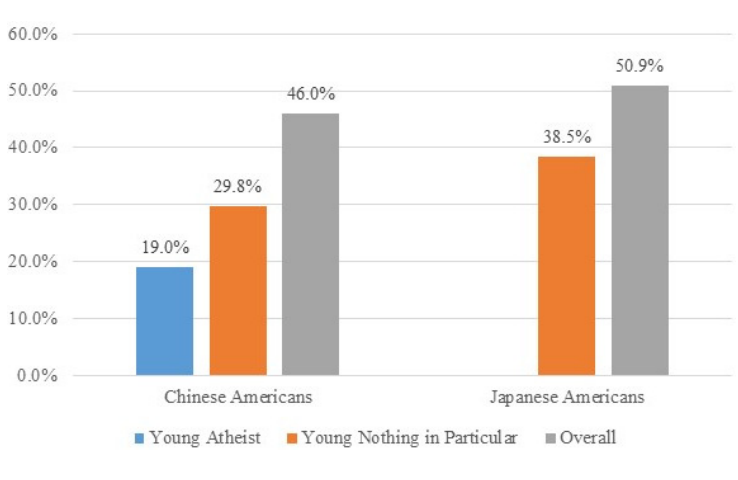
Figure 4. Belief in God or universal spirit.